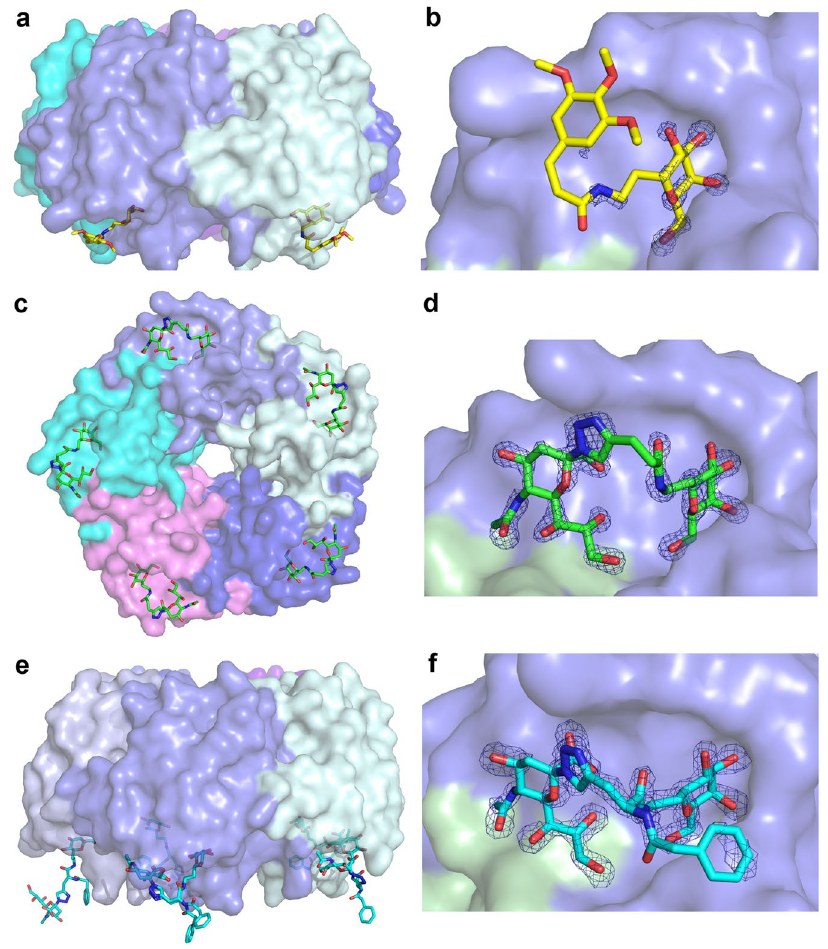
Figure 2. Structures of the toxin-antagonist complexes presented in this paper. The toxin B-pentamer is shown in 40% transparent surface representation, and the ligand in stick representation ( a , e , side view; b , c , d , f , bottom view). Panels on the right show close-up views of the inhibitor binding sites, with σ A –weighted F o - F c electron density maps contoured at 3.0 σ (generated before modelling the ligand). ( a , b ) ET CTB + 1 (yellow sticks), ( c,d ) ET CTB, in complex with 2 (green sticks), ( e,f ) pLTB R13H + 3 (cyan sticks). The figure was prepared